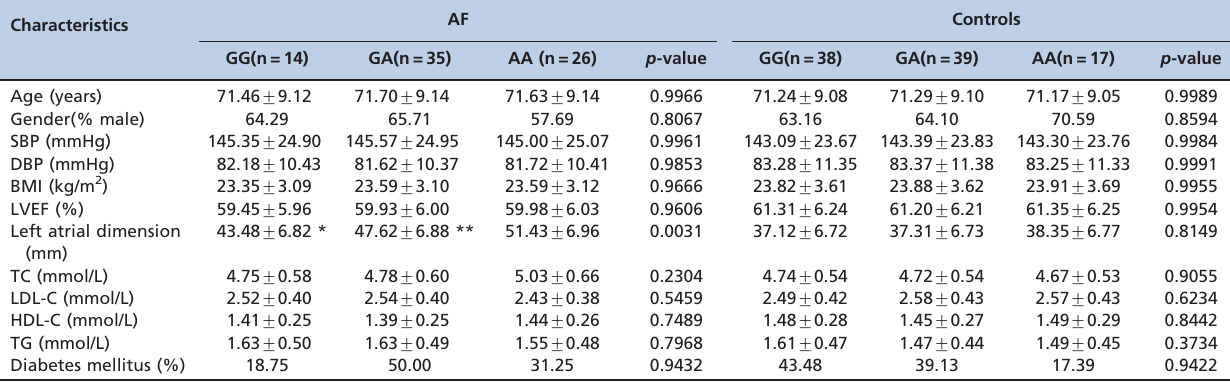
Table 3 - Clinical parameters according to different genotypes in the control and AF groups. Characteristics AF